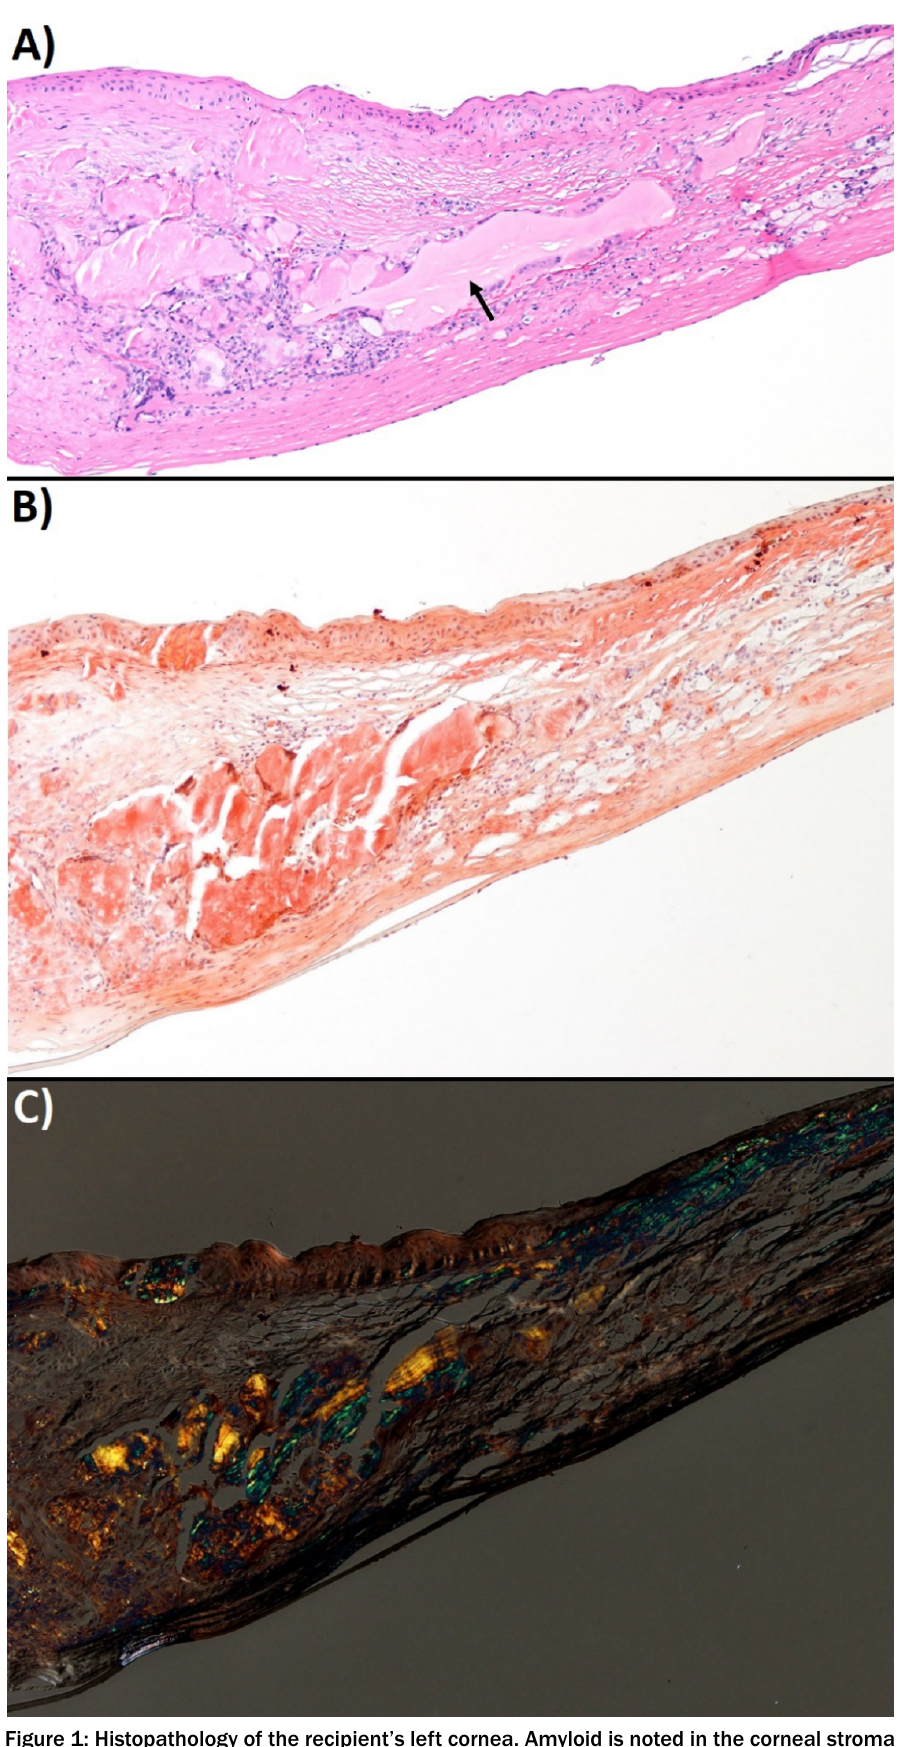
Figure 1: Histopathology of the recipient’s left cornea. Amyloid is noted in the corneal stroma on hematoxylin and eosin stain (A), congo red stain (B), congo red birefringence